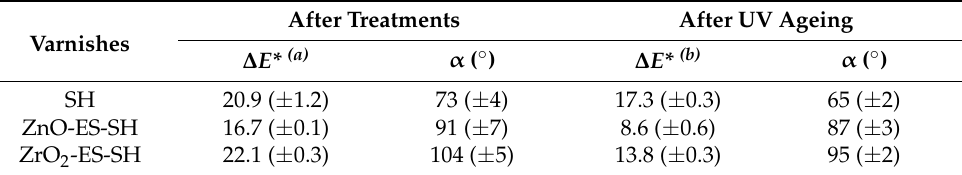
Table 2. The chromatic variations and the contact angle measurements of wood specimens after treatments and ultraviolet (UV) ageing. All data are average values from 15 measurements (three different wood specimens for each and every treatment and 5 measurements on each specimen). After Treatments After UV Varnishes